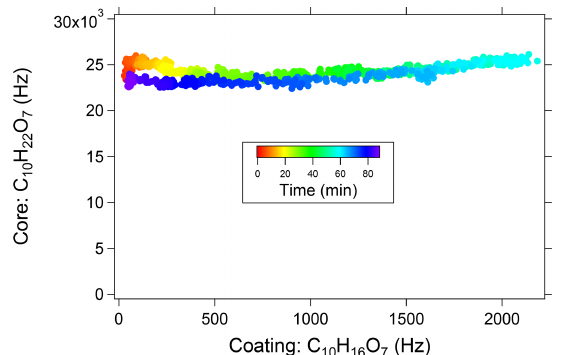
Figure 6. Dipentaerythritol [ C 10 H 22 O 7 ] Na + signal measured in a flow tube as a function of [ C 10 H H16 O 7 ] Na + signal, which is proportional to condensed SOA mass. The maximum [ C ] Na + signal corresponds to approximately 75µgm − 3 10 H H16 O 7 of SOA, of which approximately 40% occurs as a coating on the dipentaerythritol seed, increasing the particle diameter from 20 to 70nm. Points are colored by time, showing an increase and then decrease of coating